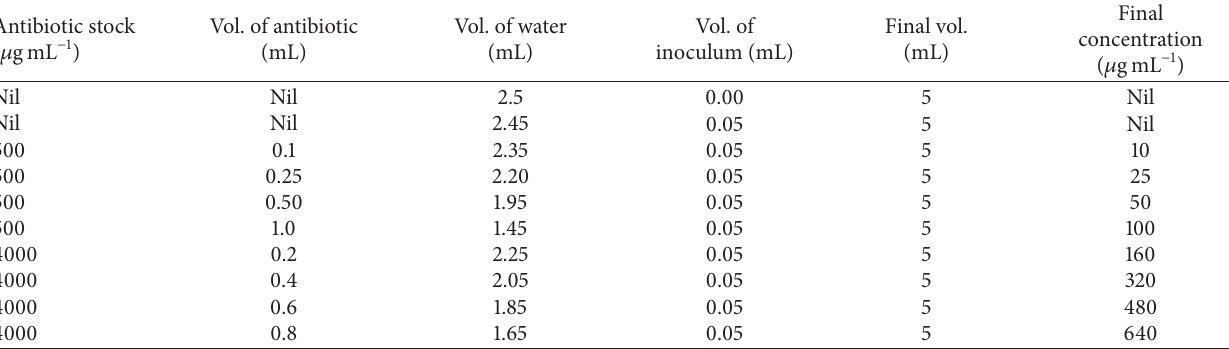
Table 1: Protocol for the determination of minimum inhibitory concentration. Antibiotic